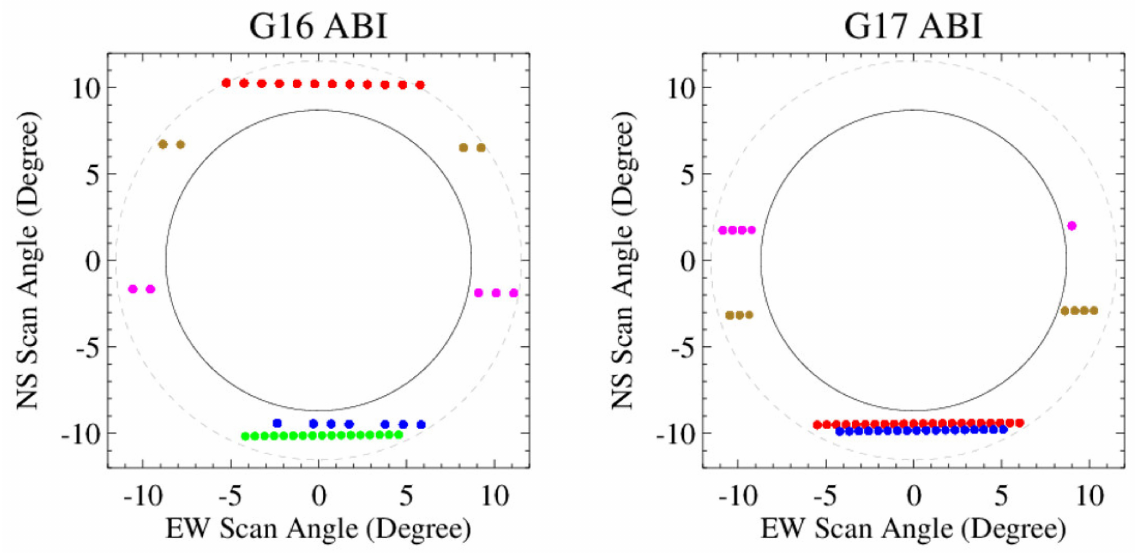
Figure 2. ABI field of regard (the outer circle in dashed gray line), Earth (the inner circle in solid black line), and the center locations of the MESO frames (dots with different colors) of the G16 ( left ) and G17 ( right ) lunar chasing events within the ABI FOR. G16 lunar chasing events: 11 February 2017 (in red), 12 February 2017 (in brown), 14 February 2017 (in pink), 4 December 2017 (in blue), and 12 July 2017 (in green); G17 lunar chasing events: 30 July 2018 (in red), 28 August 2018 (in brown), 29 August 2018 (in pink), and 20 October 2018 (in blue). Some of the G16 lunar images were not collected on 4 December